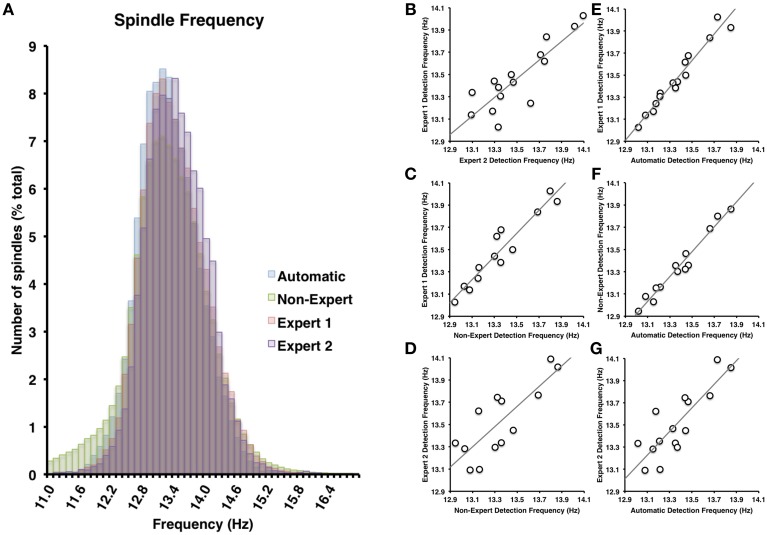
(A) There was nearly complete overlap between the four scoring methods employed (all Cohen's d < 0.25). Spindle frequency among visual identification methods (B–D) and between automatic and visual detection (E–G) were all very highly inter-correlated (all p < 0.05).